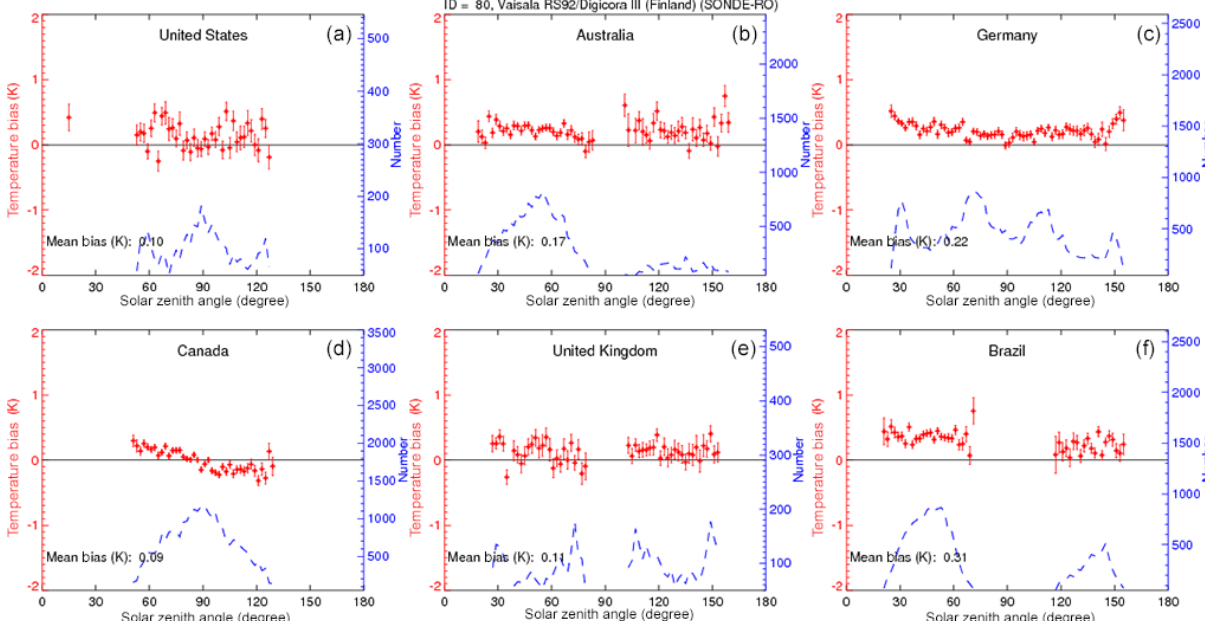
Figure 5. The mean temperature biases (RS92 minus RO) at 50hPa varying for SZA from 0 degrees to 180 degrees for (a) United States, (b) Australia, (c) Germany, (d) Canada, (e) United Kingdom, and (f) Brazil. The red cross is the mean difference for each 5 SZA bins; the red vertical line is the standard deviation of error defined as standard deviation divided by sample numbers; the vertical red lines superimposed on the mean are the standard error of the mean; the black line indicates zero mean; the blue dash line is the sample number. The right y axis shows the sample number. Only bins for more than 50 RAOB–RO pairs are